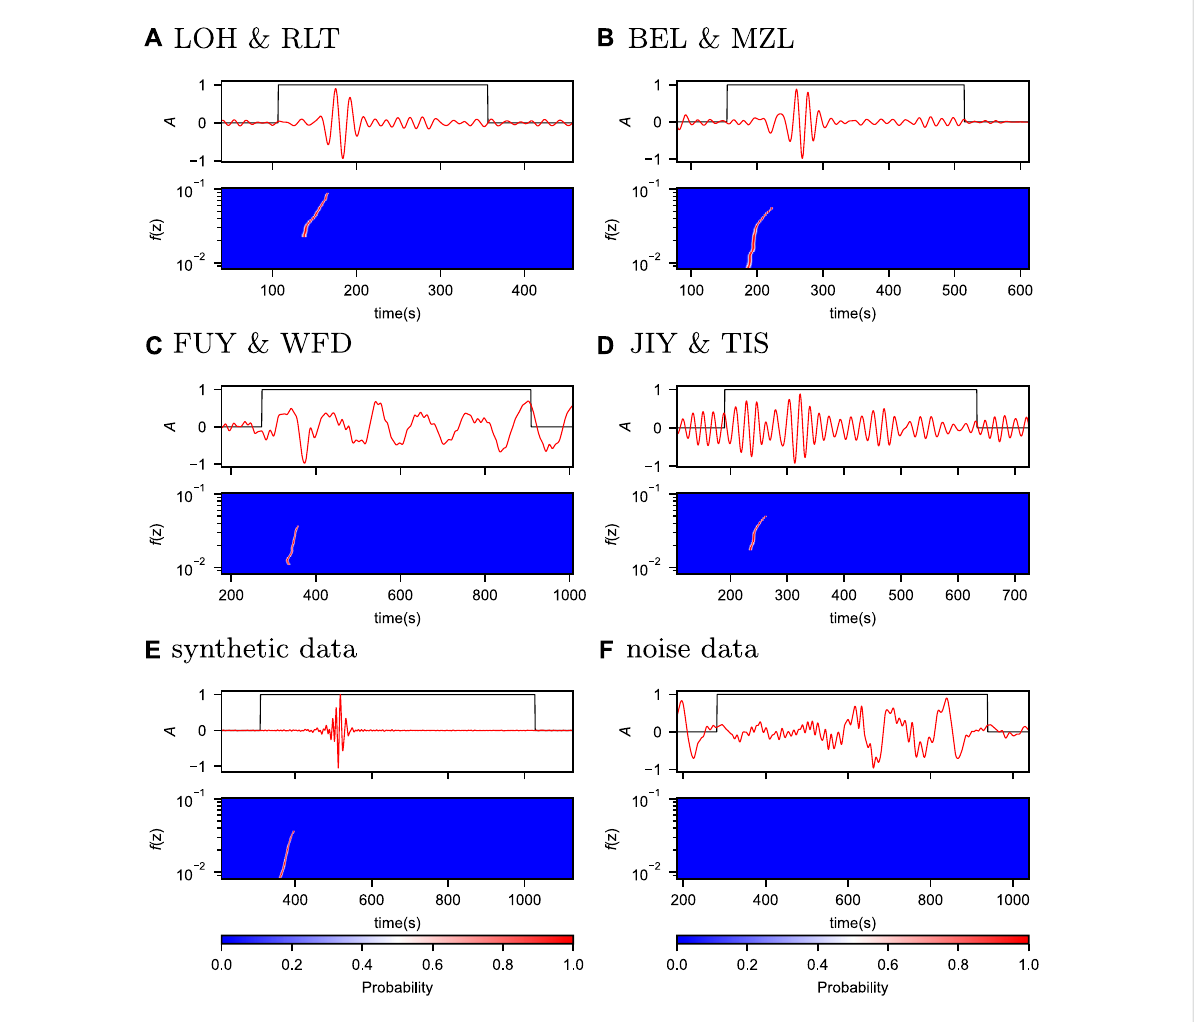
FIGURE 4 Six examples of inputs with their target outputs from the test set, four observational data (A – D) , one synthetic data (E) and one of noise (F) . The top panel in each example shows the inputs, where the red and black lines represent the CC and distance channels, respectively, and the bottom panel in each example represents the target outputs. To emphasize the primary information, we adjusted the range of shown time windows according to the corresponding inter-station